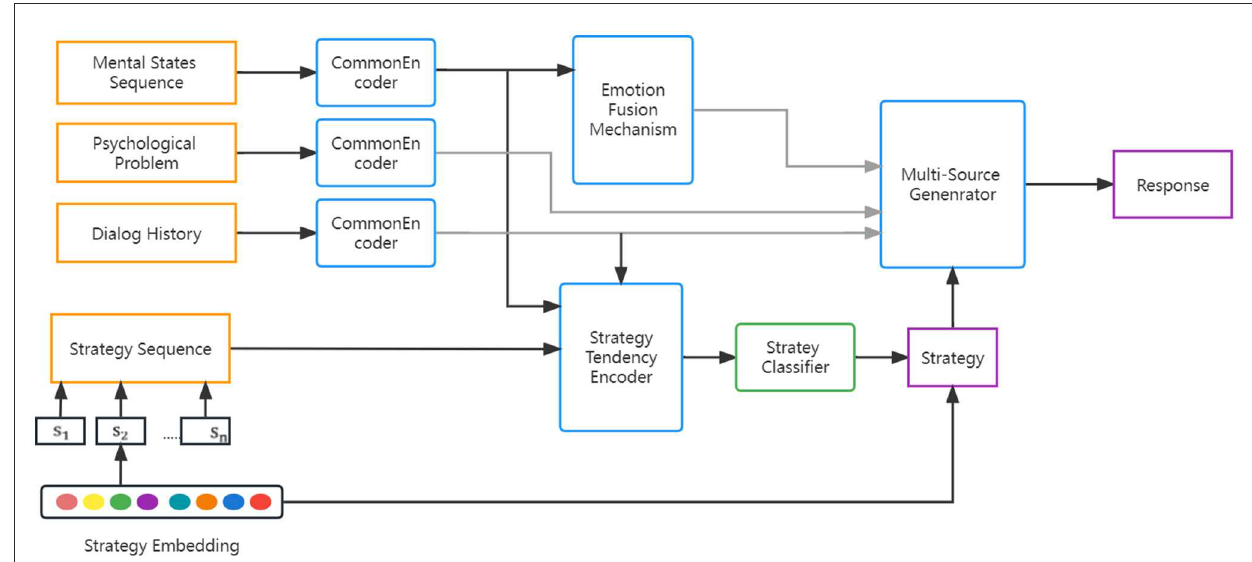
FIGURE3 Architecture of STEF agent consists of a strategy tendency encoder, an emotional fusion mechanism, and a multi-source generator.